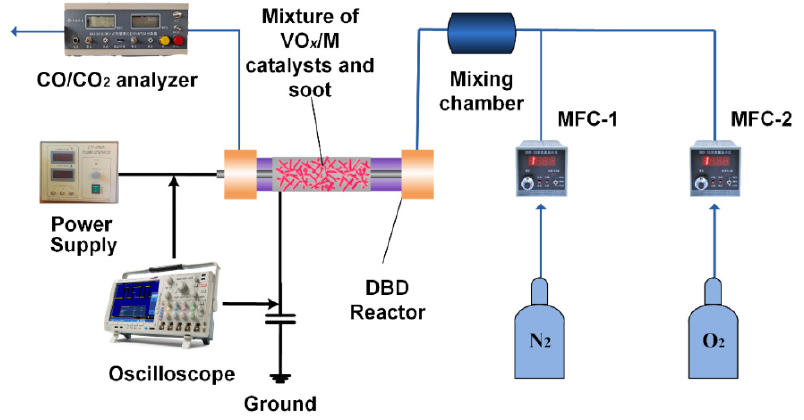
Figure 9. Experimental system for plasma-catalytic soot oxidation.